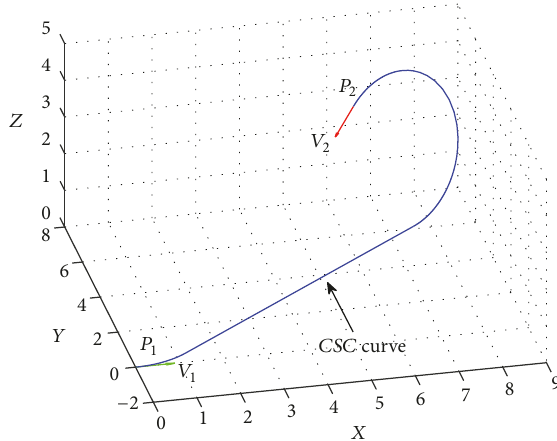
Figure 2: The result of Algorithm 1 in Dubins curve